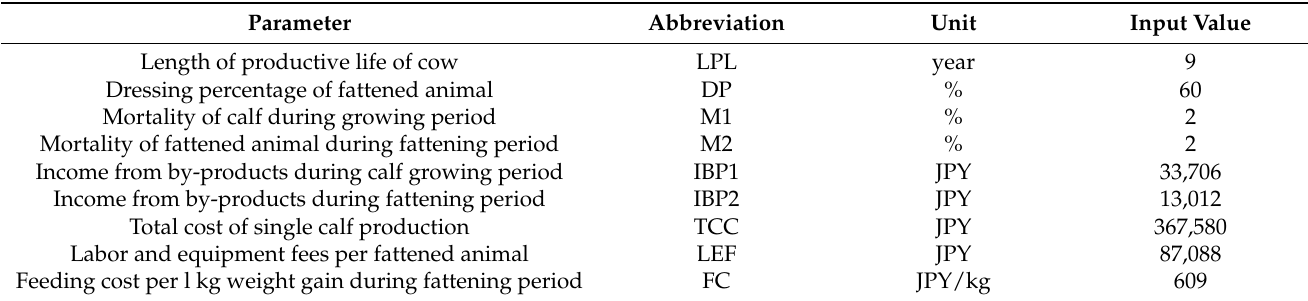
Table 2. Values of parameters used in calculating economic values 1